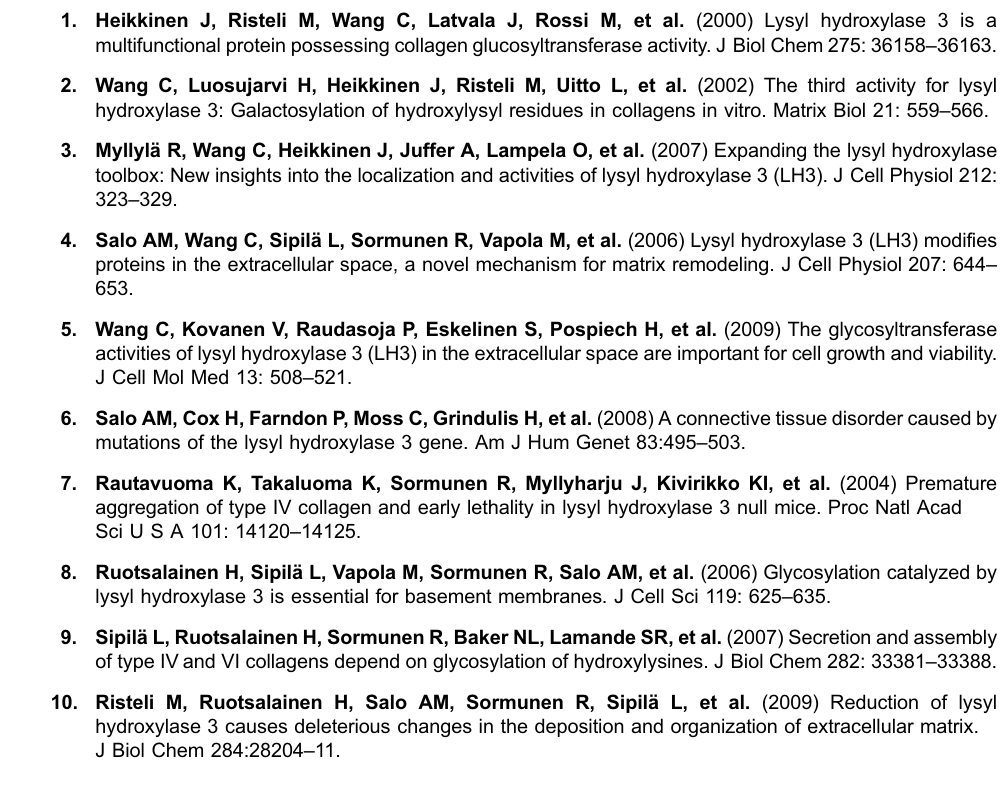
Table S1. Relative frequency of peptides from the tryptic digest of recombinant rat